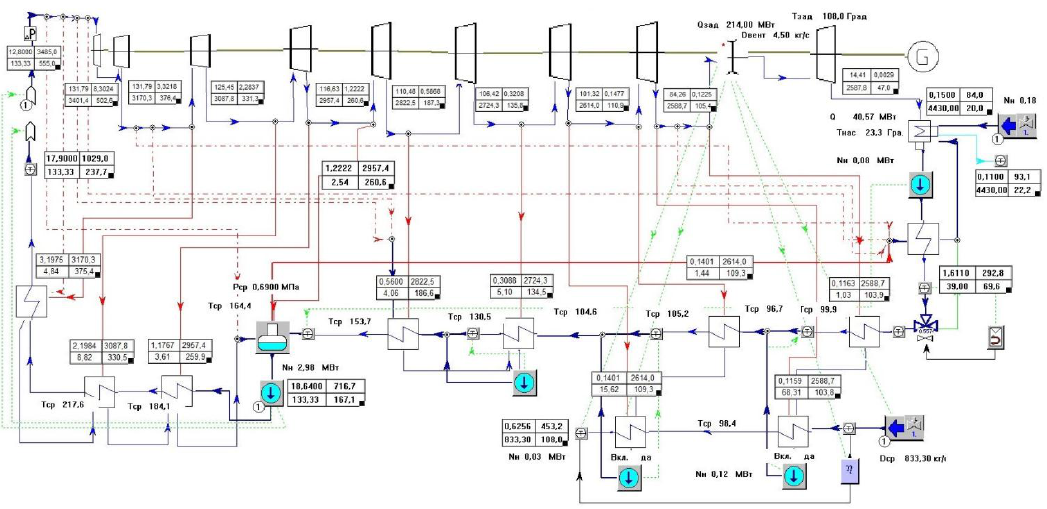
Figure 1. Standard thermal design with two inline reheaters and a rotary diaphragm controlling the heat supply.